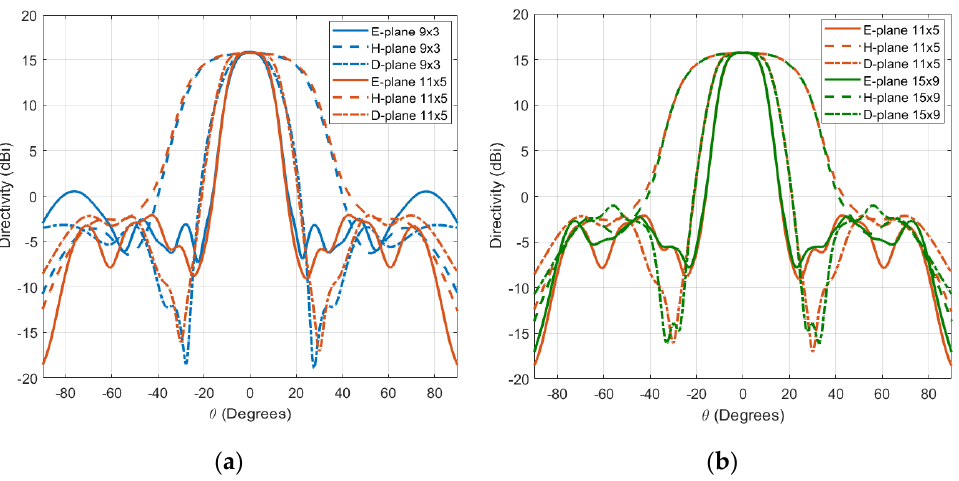
Figure 5. Embedded element pattern comparison of the central subarrays: ( a ) 9 × 3 and 11 × 5; ( b ) 11 × 5 and 15 × 9 at the design frequency f 0 = 28.0 GHz.